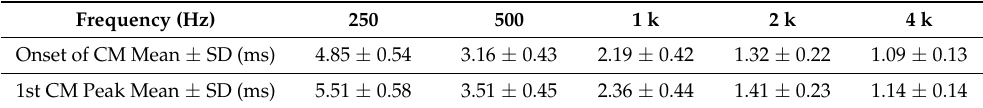
Figure 3. ( A ) The mean and standard deviation of the latency of the 1st CM peak (black line) and the latency when the CM reached 10% of the maximum amplitude (grey line); compared with previous work on basilar-membrane delays by Ruggero and Temchin (2007) [16]. ( B ) Mean (black line) and individual latencies when the CM response reached 10% of the maximum amplitude. The measured latencies of each characteristic frequency are connected with a grey line for each subject ( n = 6 at 250 Hz; n = 15 at 500 Hz; n = 16 at 1–4 kHz). Dashed lines show data of three subjects with normal hearing at 125, 250 and 500 Hz. ( C ) Comparisons of the latencies for two different groups. Group 1 contained subjects with hearing better than or equal to the PTA (125–1000 Hz) of 75 dBHL ( n = 8; n = 3 at 250 Hz; n = 8 at 500 Hz; n = 8 at 1–4 kHz). Group 2 included subjects with hearing worse than the PTA (125–1 kHz) of 75 dBHL ( n = 8; n = 3 at 250 Hz; n = 7 at 500 Hz; n = 8 at 1–4 kHz). Table 1. The mean and standard deviation of the latency of the 1st CM peak and the latency when the CM reached 10% of the maximum amplitude (( n = 6 at 250 Hz; n = 15 at 500 Hz; n = 16 at 1–4 kHz). For the minimum effect of the interest equal to SD, power higher than 0.9 was reached for sample size of 9 and higher was fulfilled for frequencies 0.5, 1, 2, and 4 kHz. For 250 Hz, power of 0.75 was